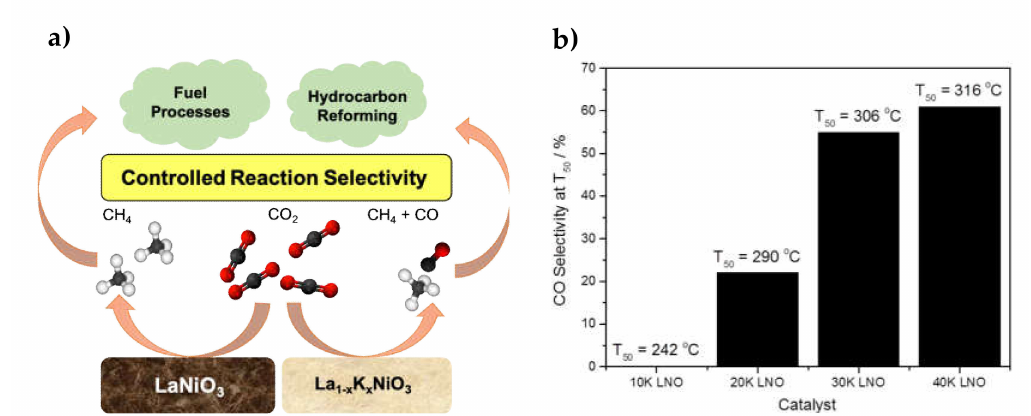
Figure 3. ( a ) CO 2 hydrogenation product selectivity for the catalysts derived from LaNiO 3 and K-substituted (La 1-x K x NiO 3 ) perovskites; ( b ) rising CO selectivity towards the RWGS at T 50% for the catalysts containing increased amounts of K. Reproduced with permission from ref. [51]. Copyright 2020